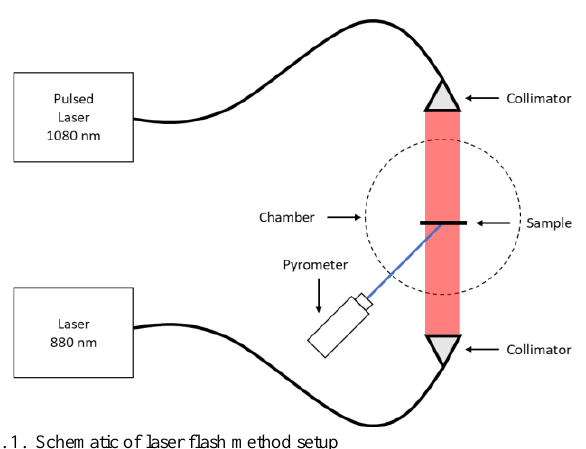
Fig. 1. Schematic of laser flash method